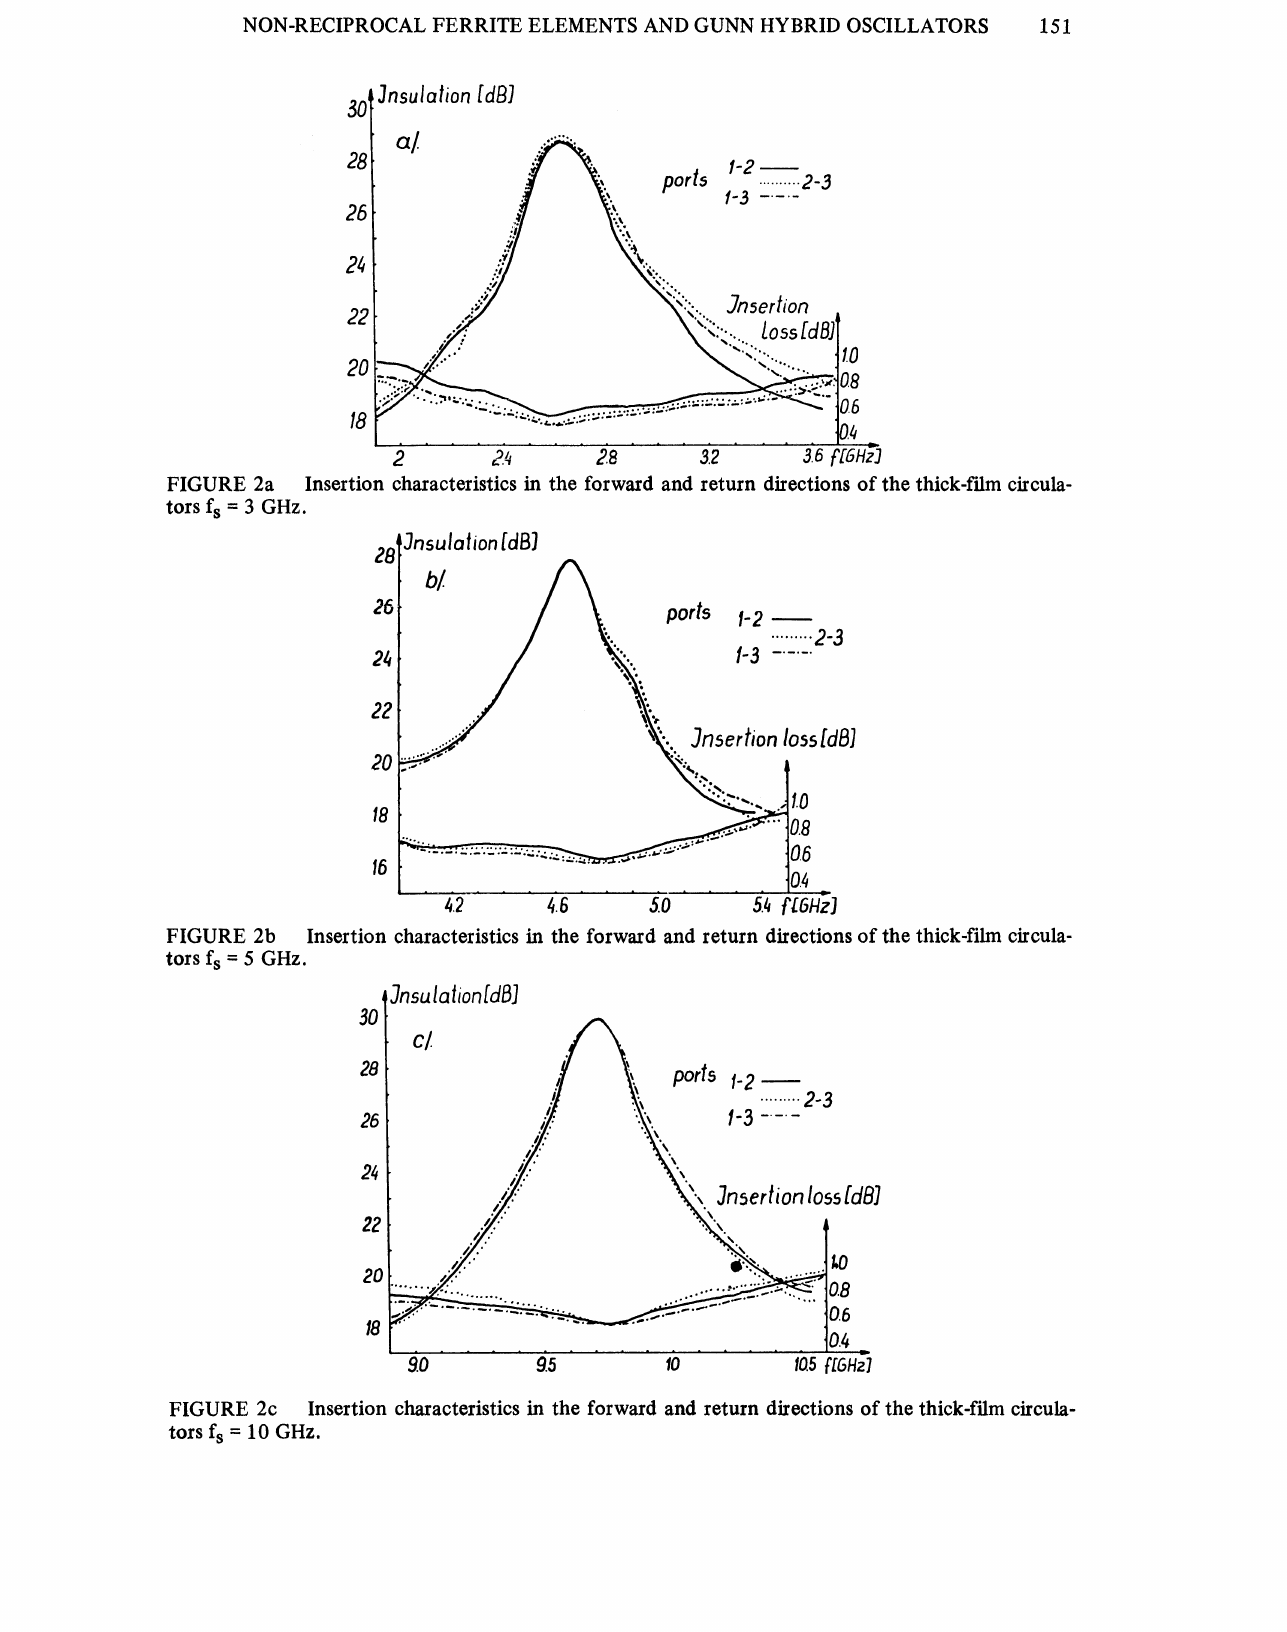
FIGURE 2c Insertion characteristics in the forward and return directions of the thick-film circula- tors fs 10